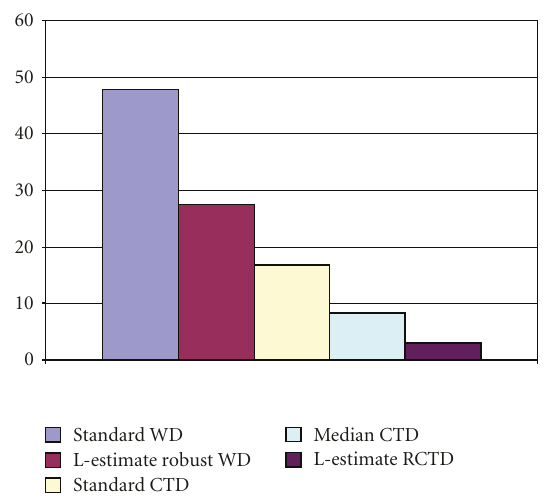
Figure 2: MSE of instantaneous frequency estimation in the presence of heavy-tailed